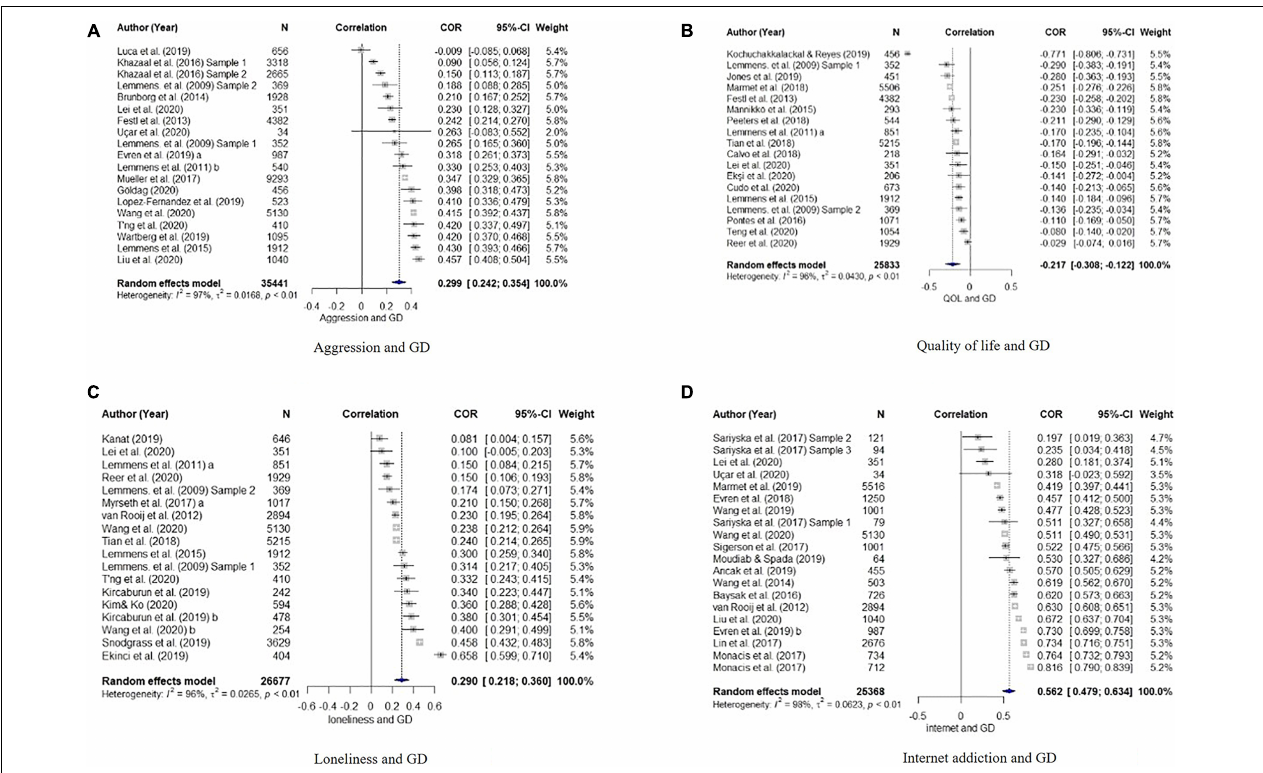
FIGURE 3 | Forest plots of correlations and 95% confidence interval (CI) for random effects meta-analysis model for (A) aggression, (B) quality of life, (C) loneliness, and (D) internet addiction.